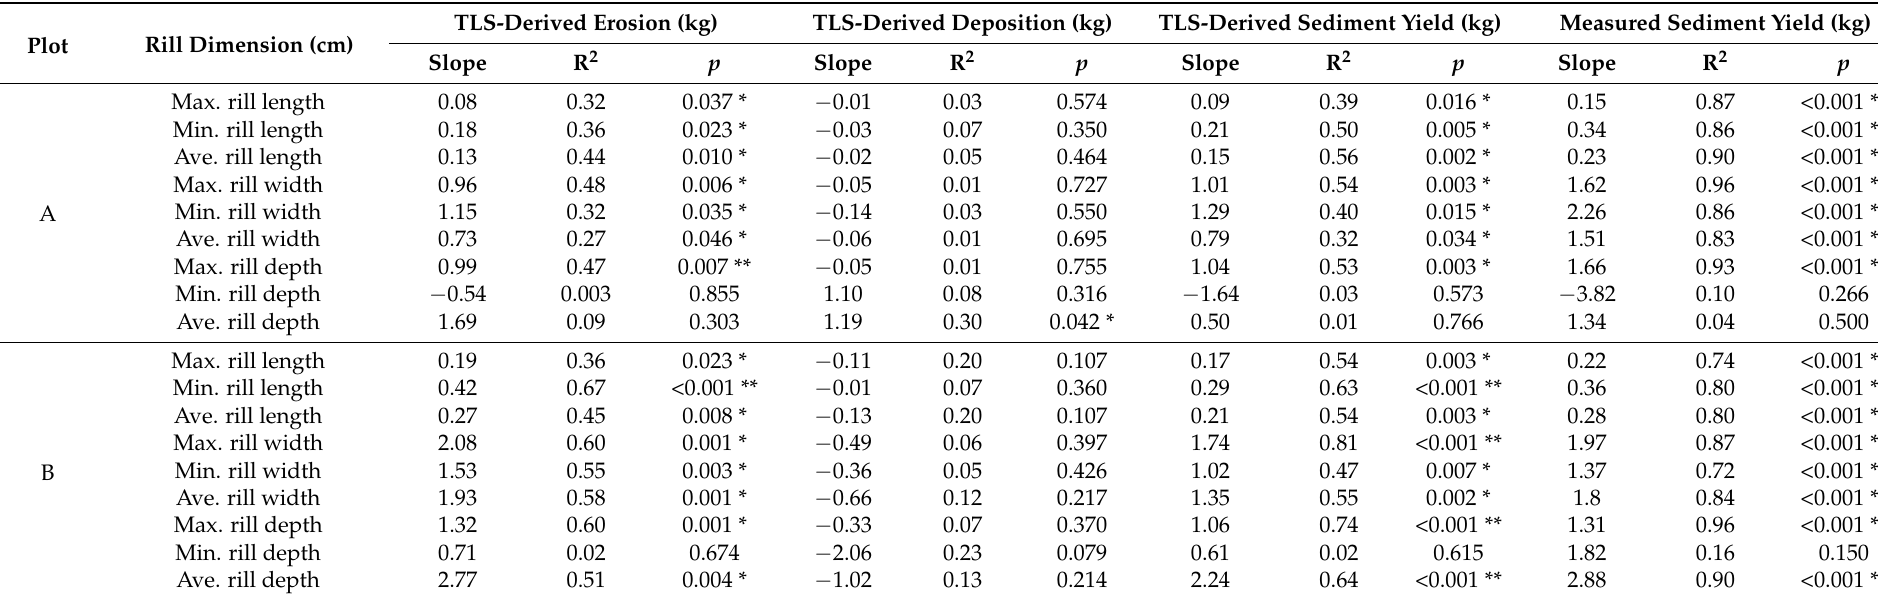
* indicates significance at p < 0.05, ** indicates significance at p <